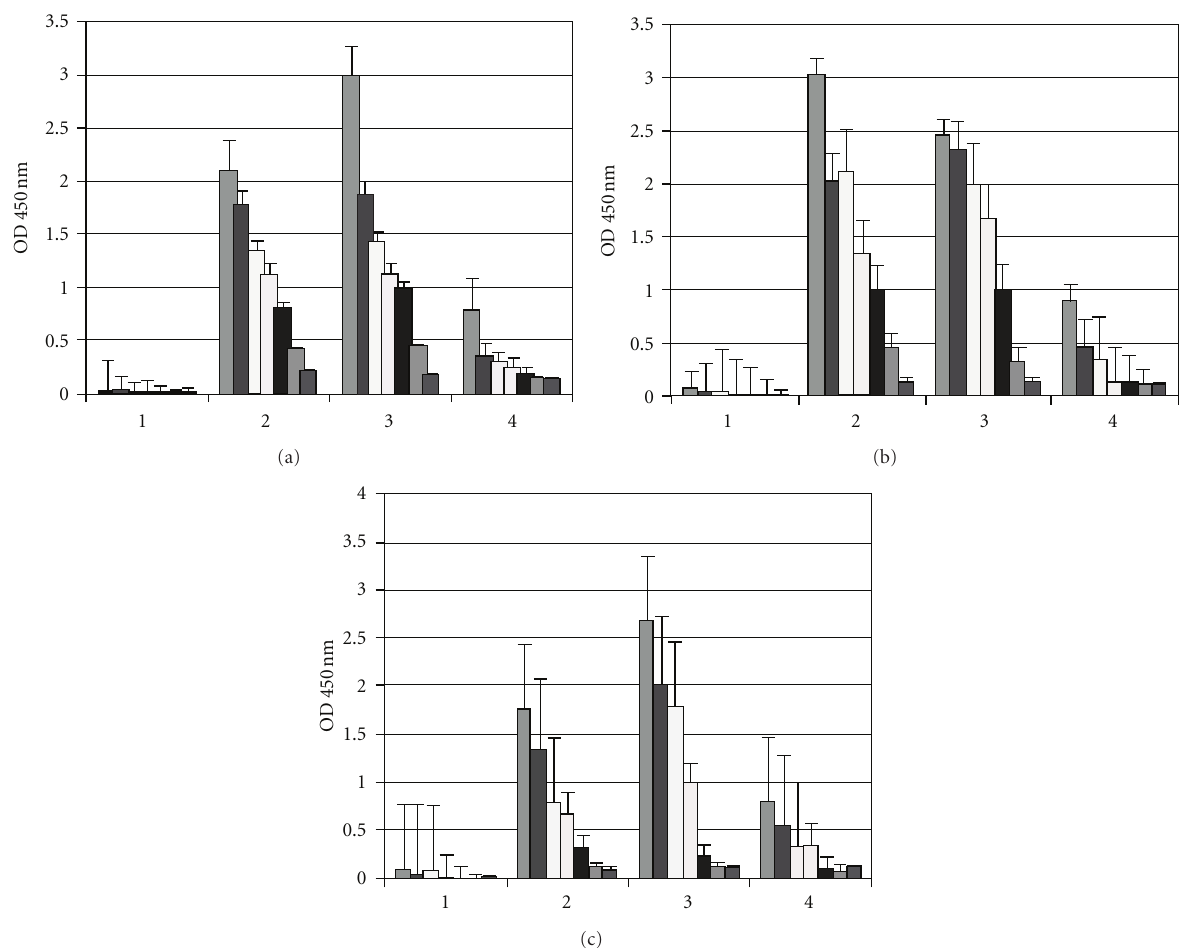
Figure 3: Antigen-specific IgG, IgM, and IgA antibody responses in serum stimulated after i.n./i.m. immunization with native OMPs of N. meningitidis at 42 days, 7 days post the i.m prime-boost, in the presence of stx1, stx2, or CT as adjuvants. (b) Sera pooled from nine mice immunized with OMPs and stx1; (a) sera pooled from eight mice immunized with OMPs and stx2; (c) sera pooled from ten mice immunized with OMPs and CT. (1) IgG, IgM, and IgA of normal mice; (2) IgG; (3) IgM; (4) IgA. Each scale bar represents the mean ± SE of nine to ten mice per group in an experiment representative of two separate experiments. (a) OMPs and stx1- IgG, IgM, and IgA containing formulations versus normal sera ( P < 0 . 001), (b) OMPs and stx2 IgG, IgM, and IgA containing formulations versus normal sera ( P < 0 . 001); (c) OMPs and CT IgG, IgM, and IgA containing formulations versus normal sera ( P < 0 .